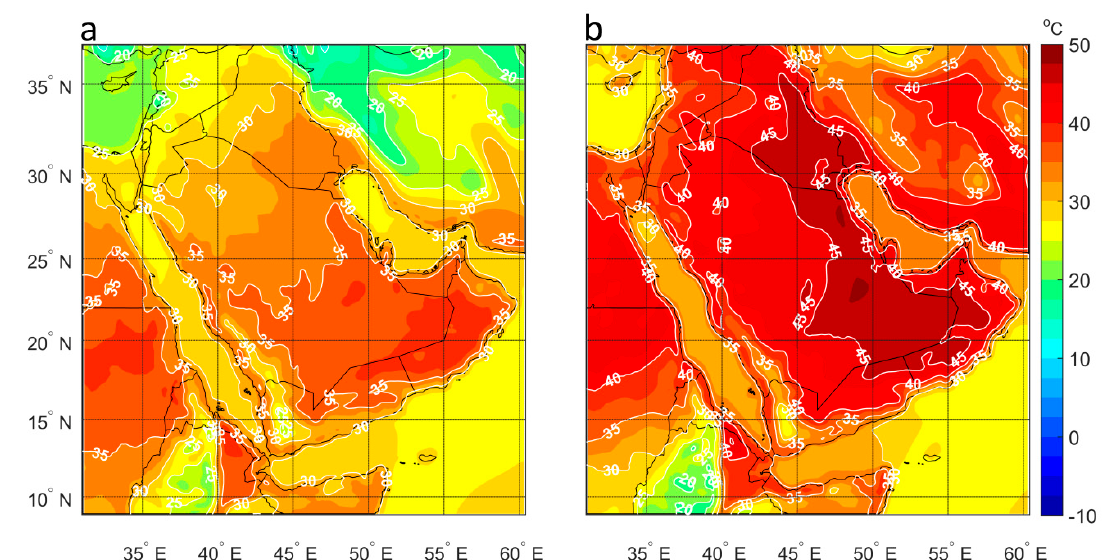
Figure 7. Annual mean of daily maximum temperature ( a ) and mean daily maximum temperature in July ( b ).